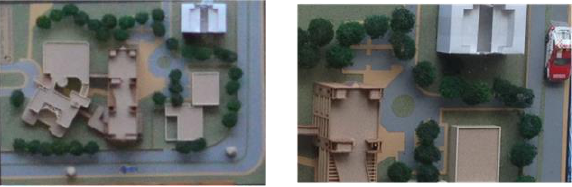
Figure 9. Image captured of Rajeev Motwani Building model in IIT Kanpur by Nikon D-5100 camera (left) from 20 m and mobile phone camera (right) from 1 m